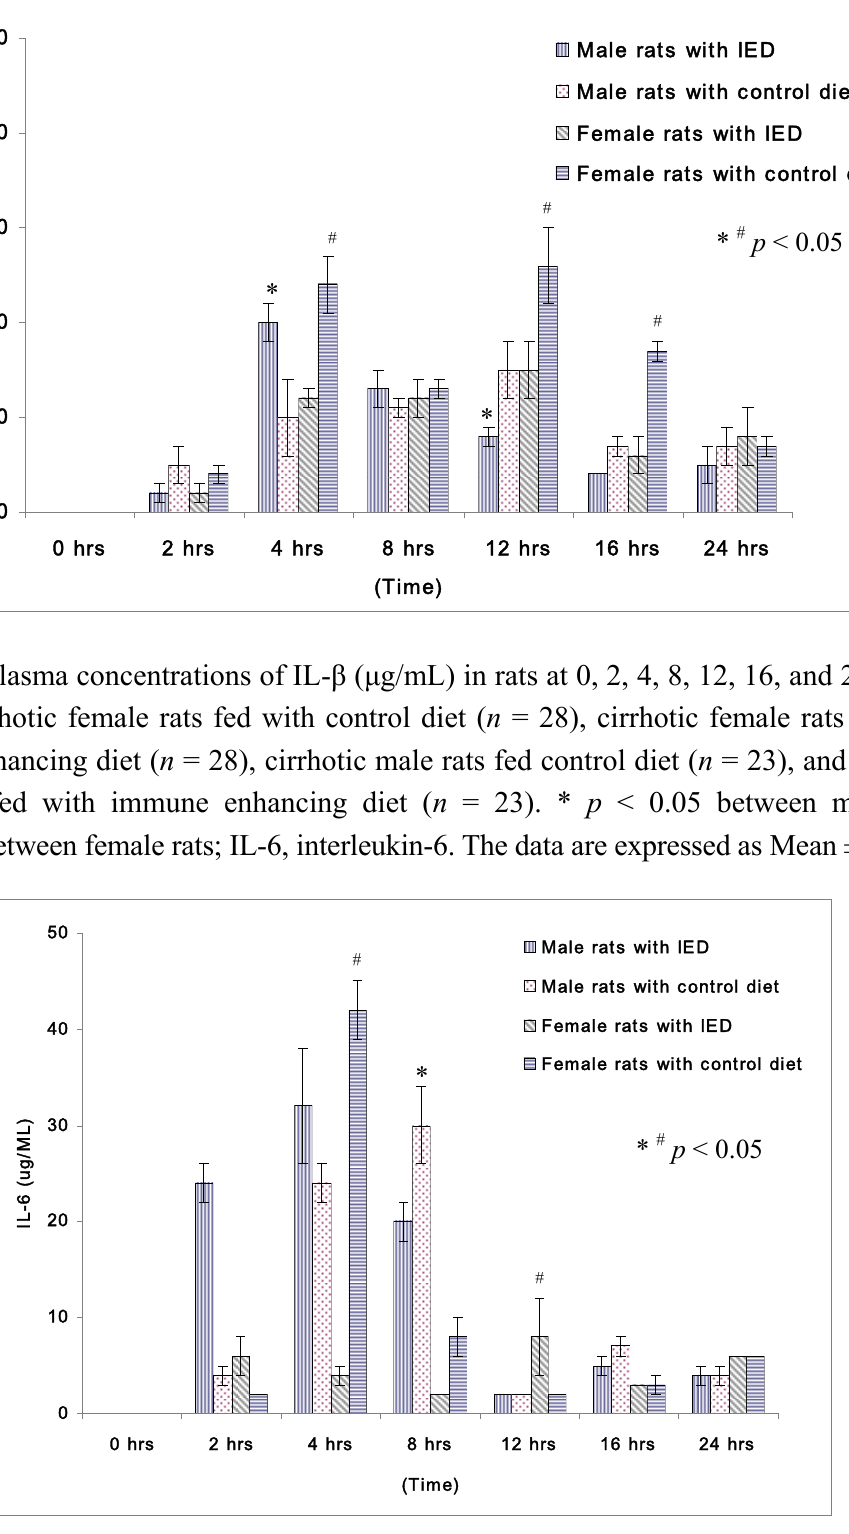
Figure 1. Plasma concentrations of IL-1 β ( μ g/mL) in rats at 0, 2, 4, 8, 12, 16, and 24 h after CLP in cirrhotic female rats fed with control diet ( n = 28), cirrhotic female rats fed with immune enhancing diet ( n = 28), cirrhotic male rats fed with control diet ( n = 23), and cirrhotic male rats fed with immune enhancing diet ( n = 23). * p < 0.05 between male rats; # p < 0.05 between female rats; IL-1 β , interleukin-1 β . The data are expressed as Mean ± SEM.